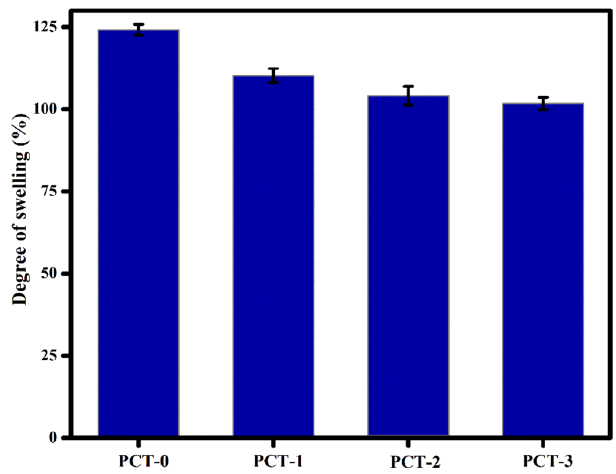
Figure 11. Degree of swelling of PVA/CMC/TUR films.